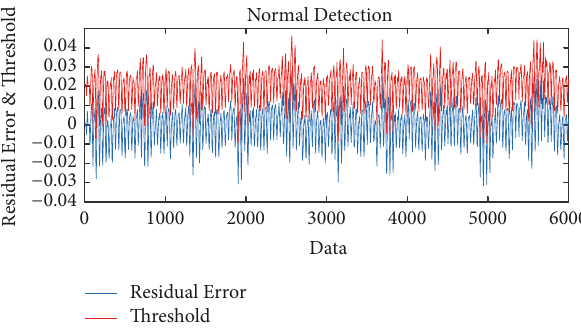
Figure 6: Detection result under normal status.